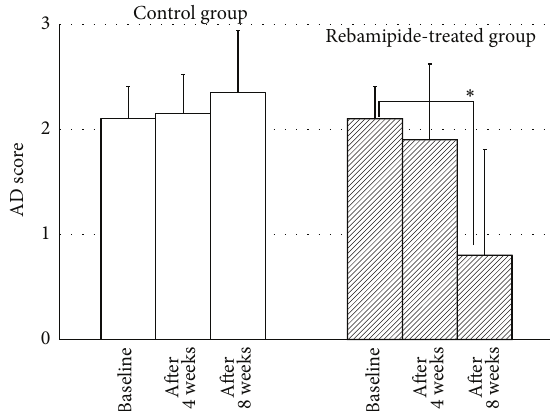
Figure 2: Changes in fluorescein uptake in the rebamipide-treated group and control group. Significant decreases in fluorescein uptake were observed in eyes treated with rebamipide after 4 and 8 weeks compared with baseline. ∗ 𝑃 < 0.05 .